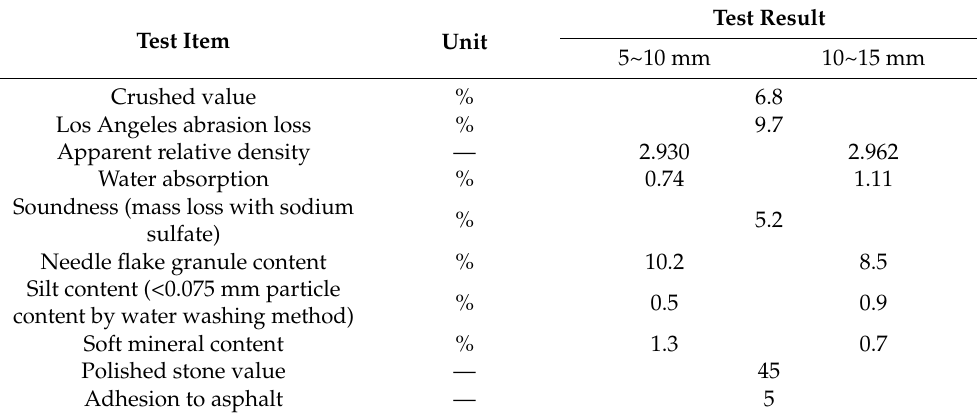
Table 2. Test results of technical indicators of coarse aggregate.